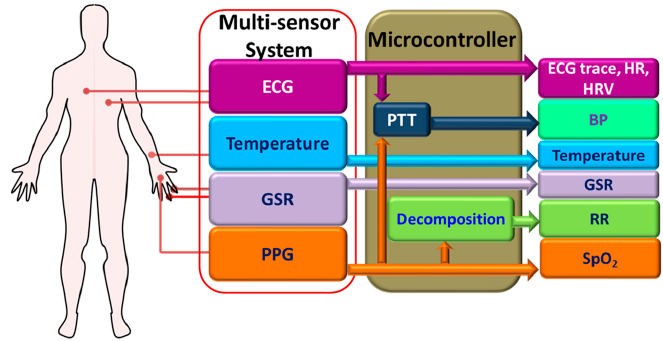
Figure 8. Four sensor health monitoring system [16].